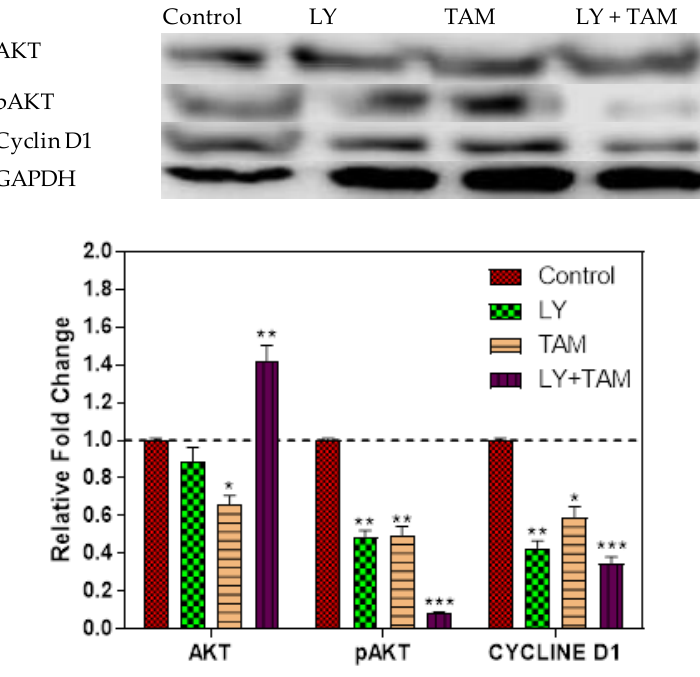
Figure 7. MCF-7 cells were incubated with control, LY, TAM, and LY + TAM for 24 h. Proteins from total cell lysate were separated by SDS-PAGE gel electrophoresis, and immunoblotted with antibodies against AKT, phosphorylated AKT, and cyclin D1. The color density was quantified using densitometry). Statistical differences, compared with the control cells, were assessed by a one-way ANOVA with the Tukey’s post -hoc multiple comparison test (GraphPad Prism). p < 0.05 (*), p < 0.01 (**) and p < 0.001 (***) were taken as significant.